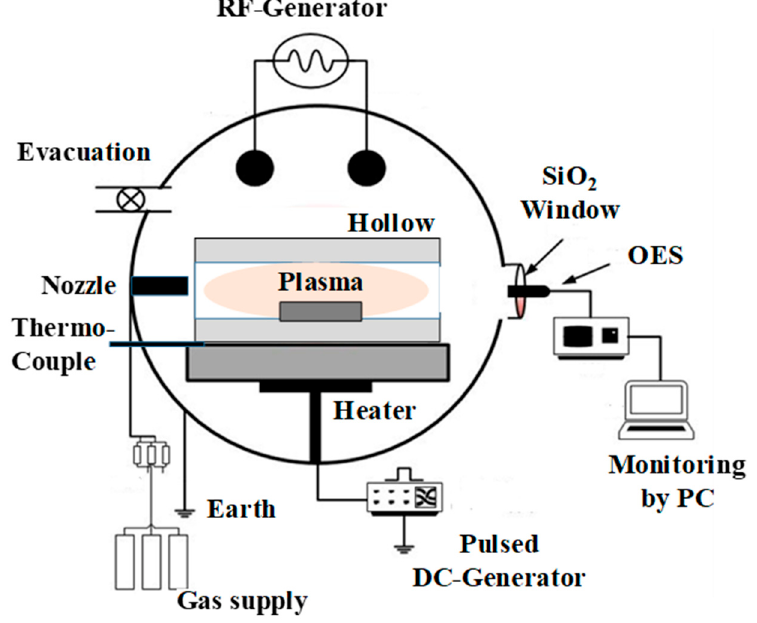
Figure 1. RF-DC plasma nitriding system with instrumentation of OES for monitoring the emissive light spectra from N 2 + H 2 plasmas.